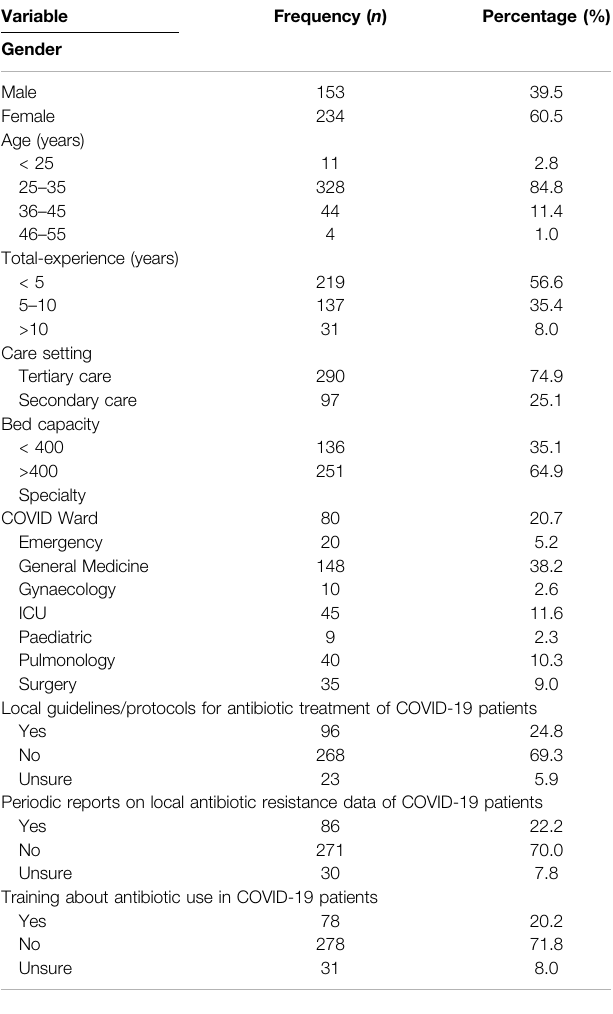
TABLE 2 | Demographic and information of study participants ( n (cid:1)